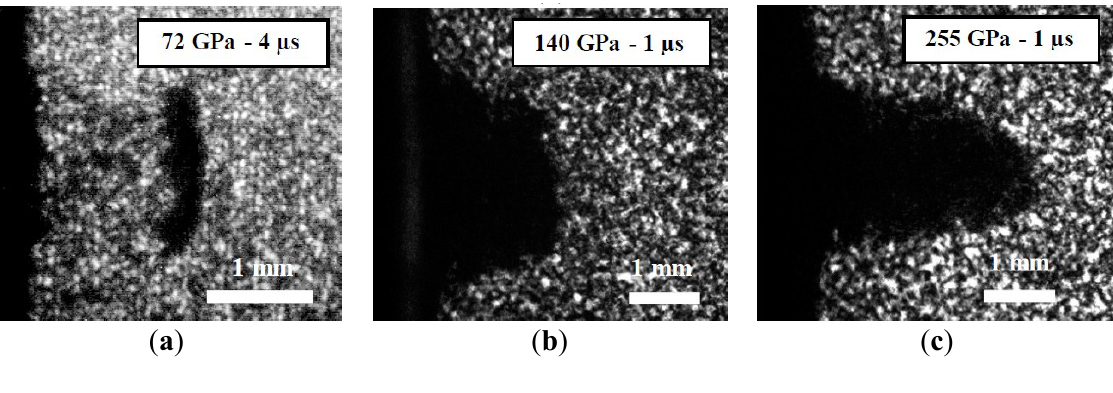
Figure 7. Optical shadowgraphs recorded behind the free surface of Fe targets of thickness 150 µm ( a ): or 100 µm ( b ) and ( c ), subjected to laser shocks of increasing